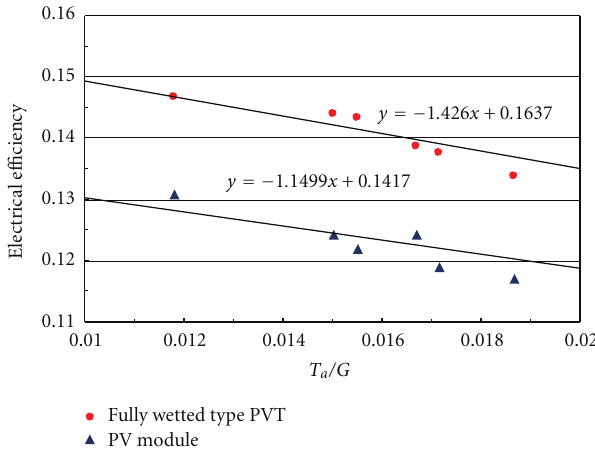
Figure 10: Electrical E ffi ciency of the fully wetted type of PVT collector and a PV module of as a function of the ambient temperature and solar